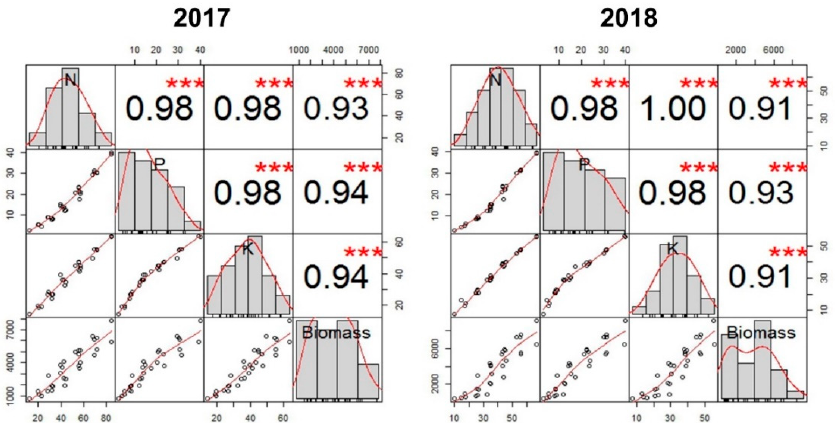
Figure 8. Correlation between N, P, K, and reproductive organ biomass during 2017 and 2018 cropping seasons. The bars and line, shown with observation, are regarded as correlation coe ffi cients as 1 (R = 1). Other line graphs and correlation coe ffi cients represent the comparative values to R = 1. Where *** showed very highly significant ( p ≤